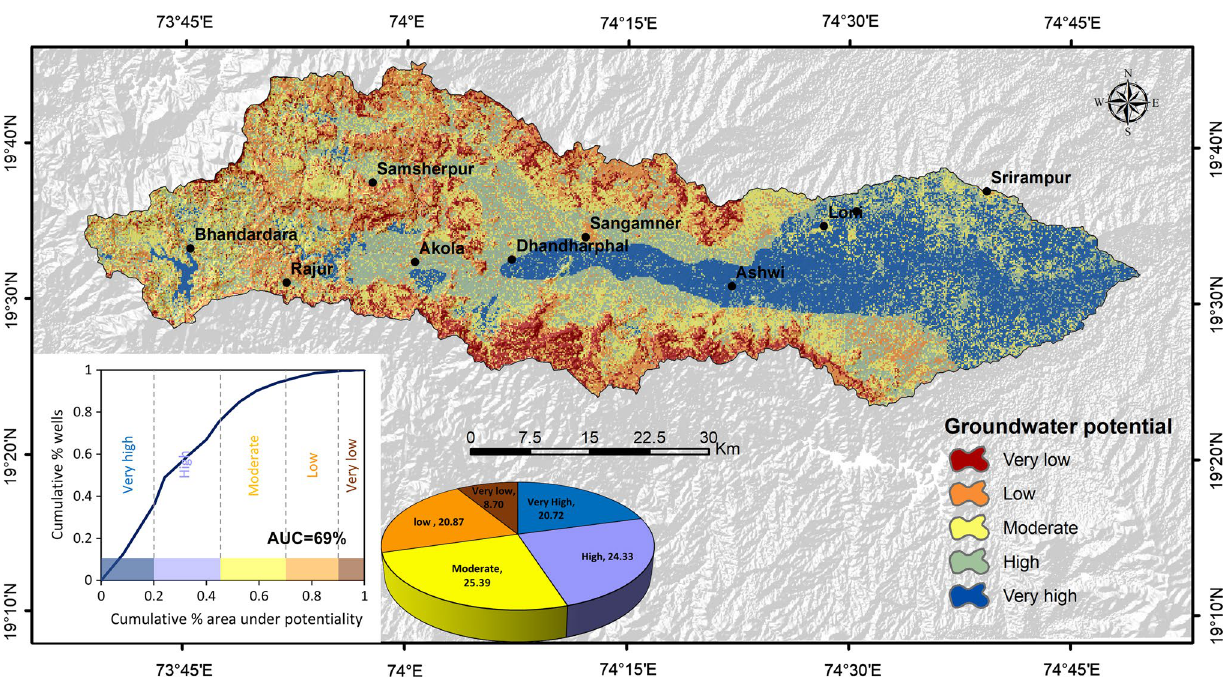
Fig. 13 Groundwater potential map of the study area derived through influencing factors method. Inset dots are showing the major loca- tions in Pravara basin. The relationship between cumulative area